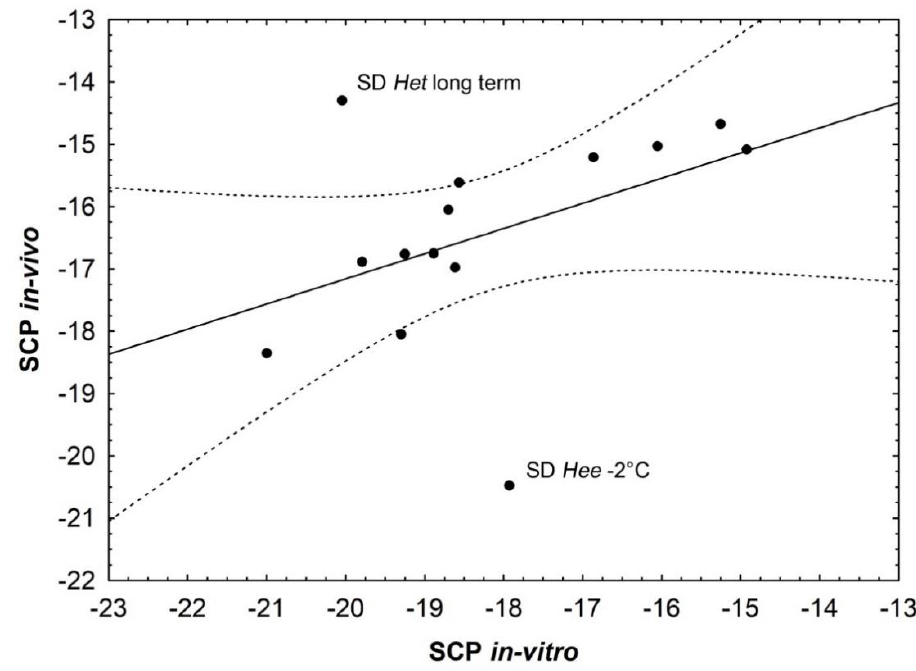
Figure 2. A correlation between the in vitro and the in vivo SCP values (correlation coefficient = 0.43, p < 0.05) shows the two groups that differ strongly between the two different measurements as clearly outside of the 95% confidence interval (dashed lines) of the correlation.